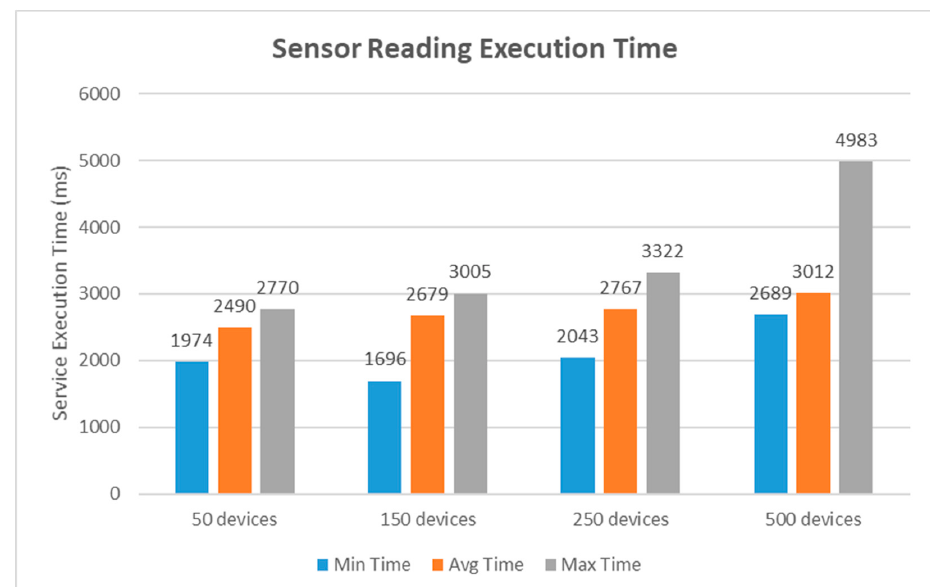
Figure 16. Performance analysis graph of the sensor reading.